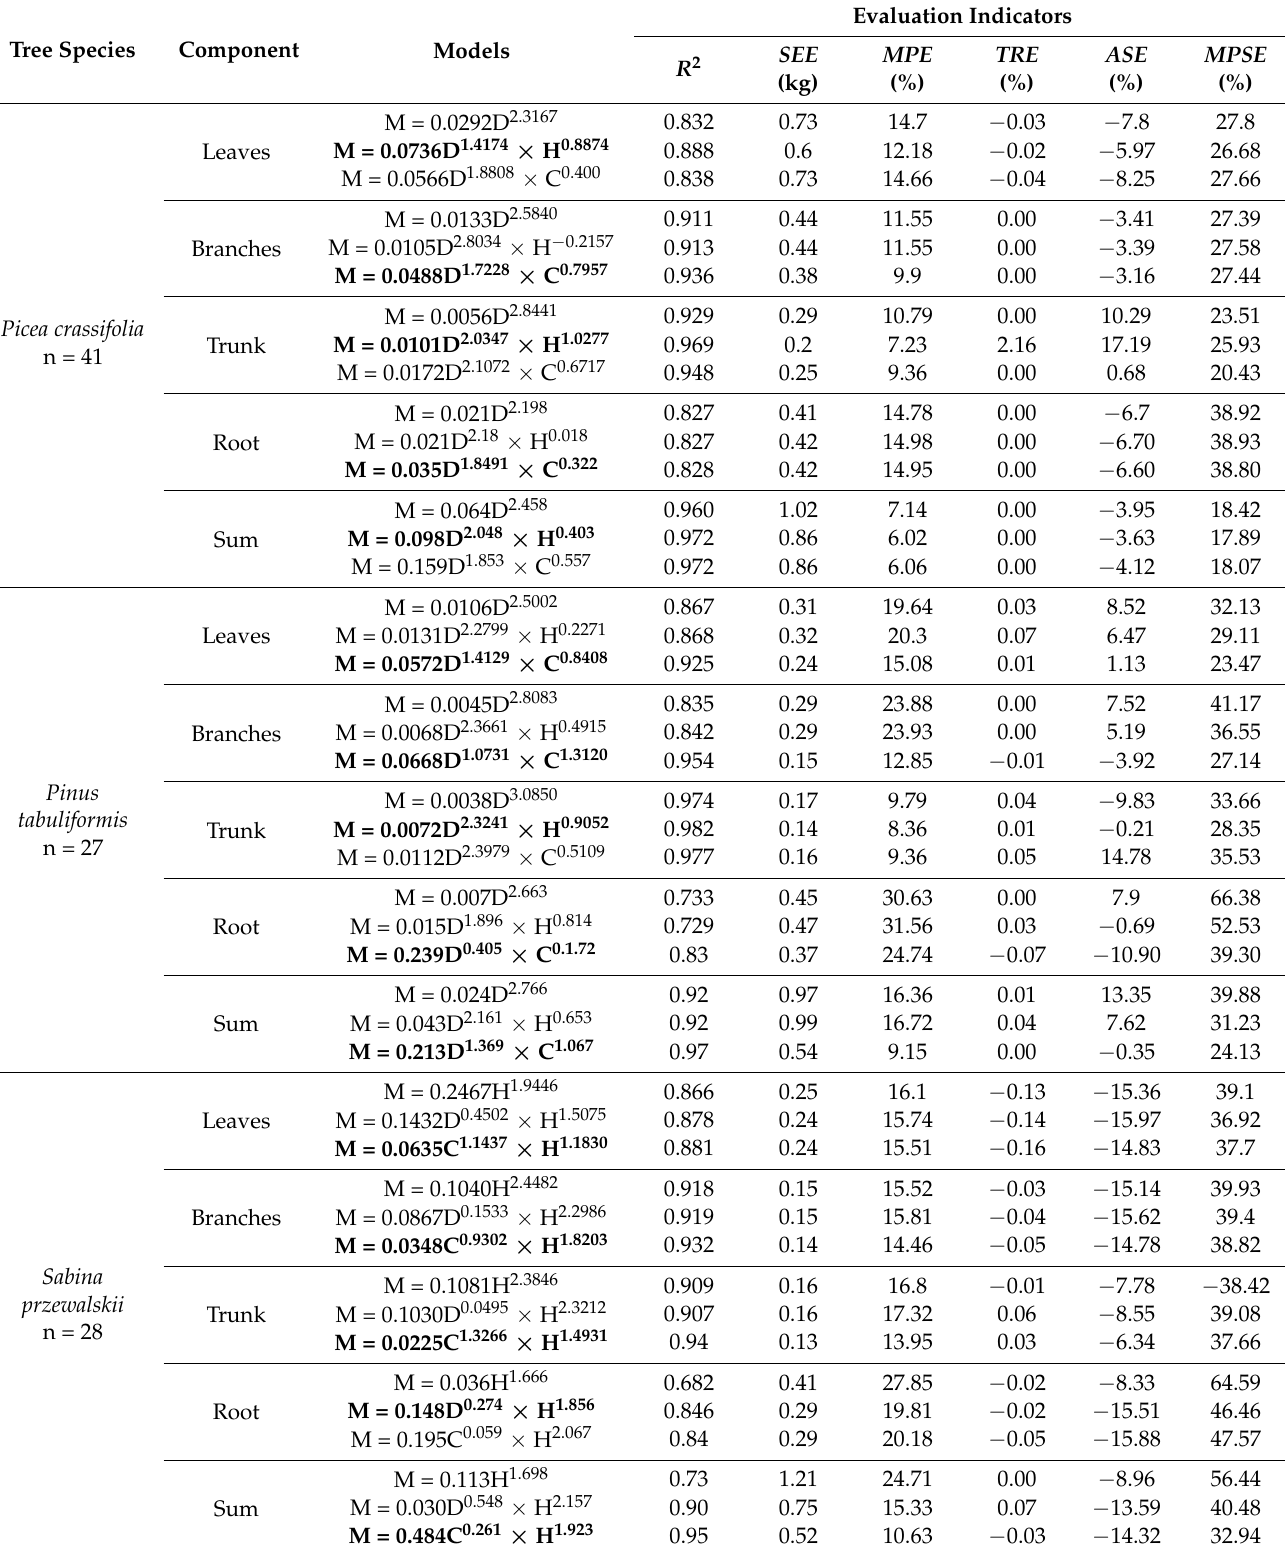
Table 3. Independent biomass models of the young wood of three tree